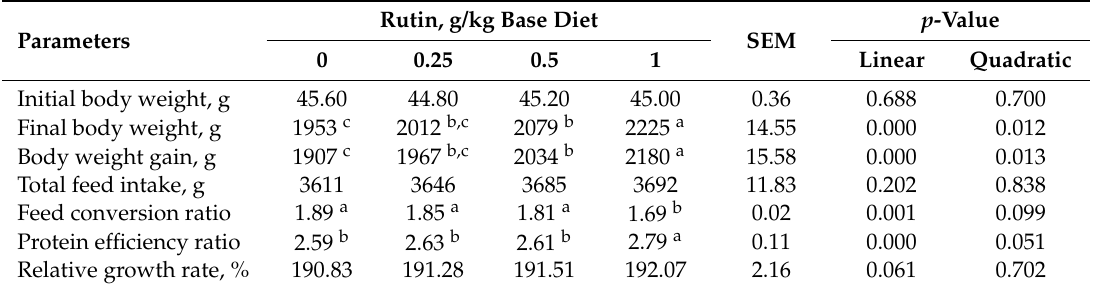
Table 3. Effect of dietary rutin supplementation on the performance traits of broiler chickens.